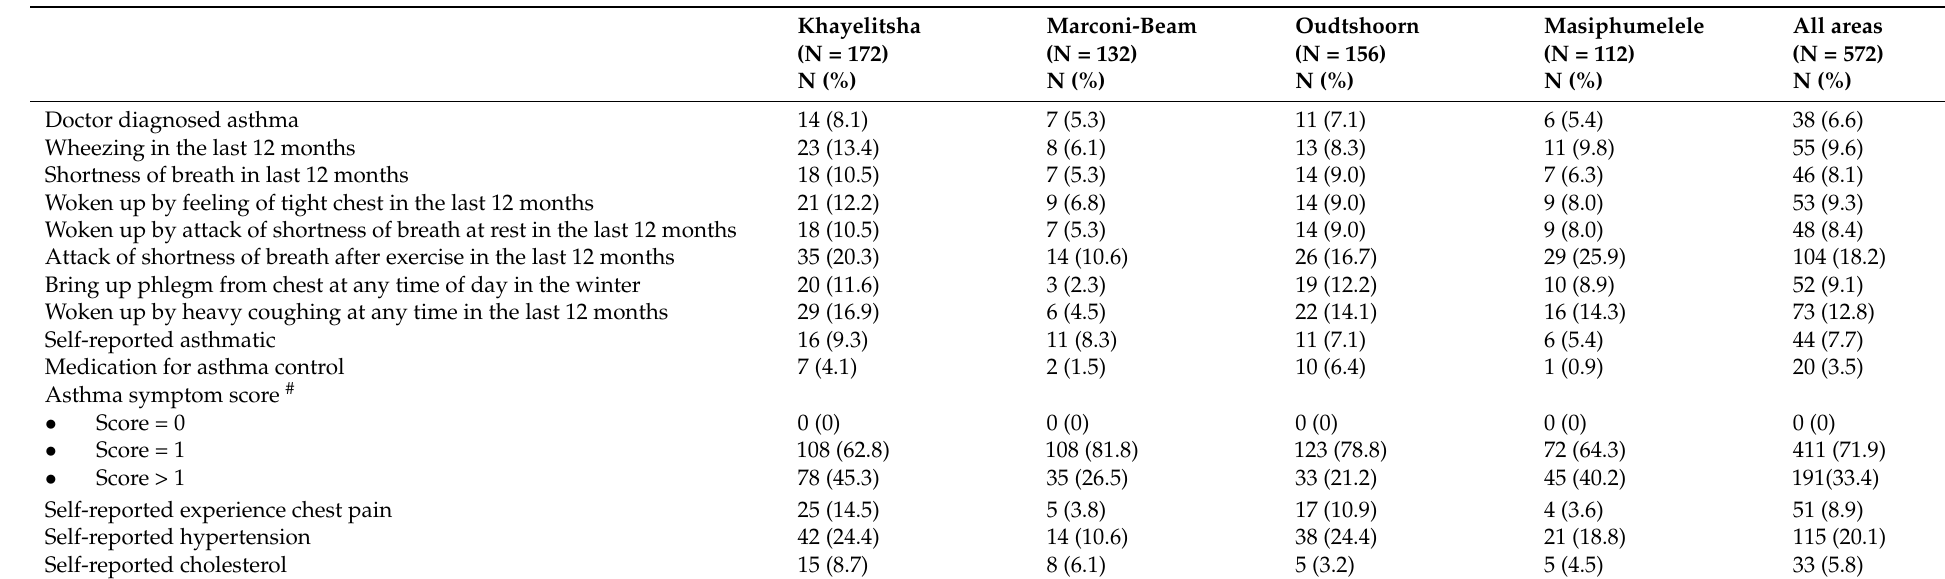
Table 3. Cardiorespiratory outcomes of the study participants across the four study